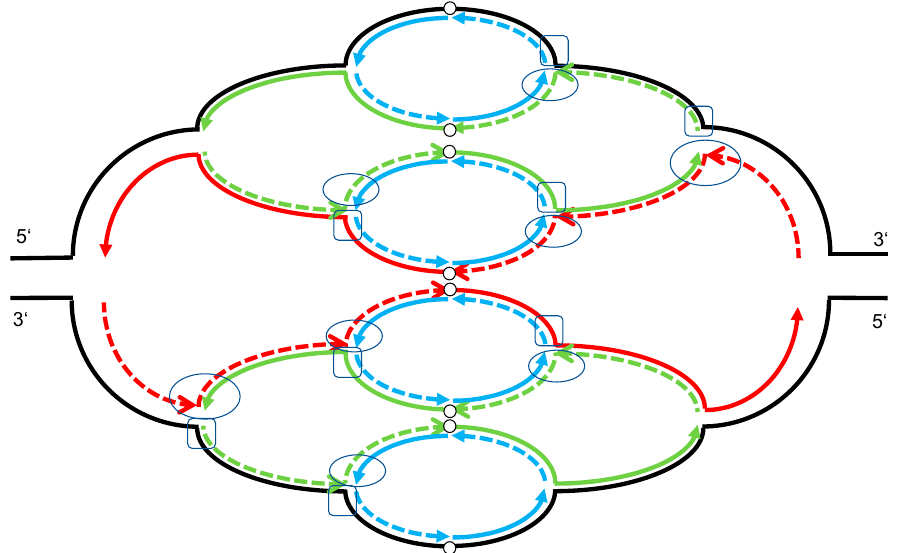
Figure 2. Double strand break (DSB) and single strand break (SSB) generation by re-replication. This scheme summarizes three rounds of replication with closed lines representing the leading strand and interrupted lines representing the lagging strand. Arrows indicate the synthesis direction of the replication. Origin of replications are indicated by open circles. The first round of replication is shown in red, the second in green and the third in blue. As proposed by Alexander [43] DSBs were generated when a leading strand from a second replication fork hits unligated Okazaki fragments on the lagging strand of an earlier fork as indicated by light blue circles. SSBs are very likely also generated in the lagging strand at this fork collision points as indicated by light yellow rectangles. Interestingly in primary cells as BJ and IMR90 cells, CDT1 overexpression leads to limited re-replication at cellular replication origins with none of the replicating cells show- ing more than 4N DNA content [44]. In addition, SV40 T expressing BJ cells revealed mul- tiple re-replication rounds, but only at SV40 origins. DSBs were observed in both cases but did not disturb cell growth. Truong and colleagues hypothesize that in primary cells